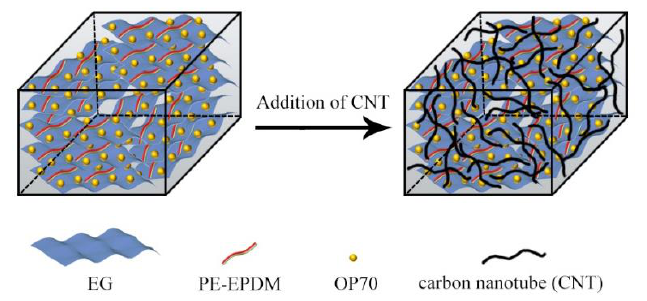
Figure 2. SEM images of CNT/PE-EPDM/EG-based phase change composites (C1~C6).